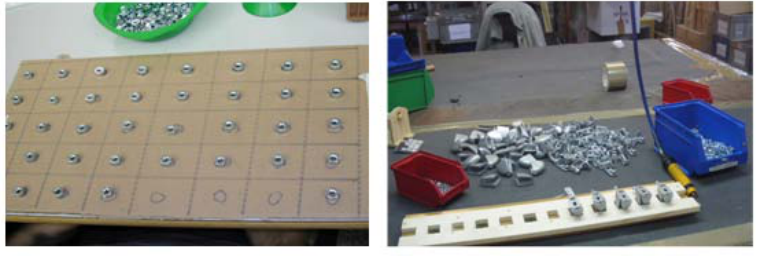
Figure 1. Poya-Yoke designed for counting parts in